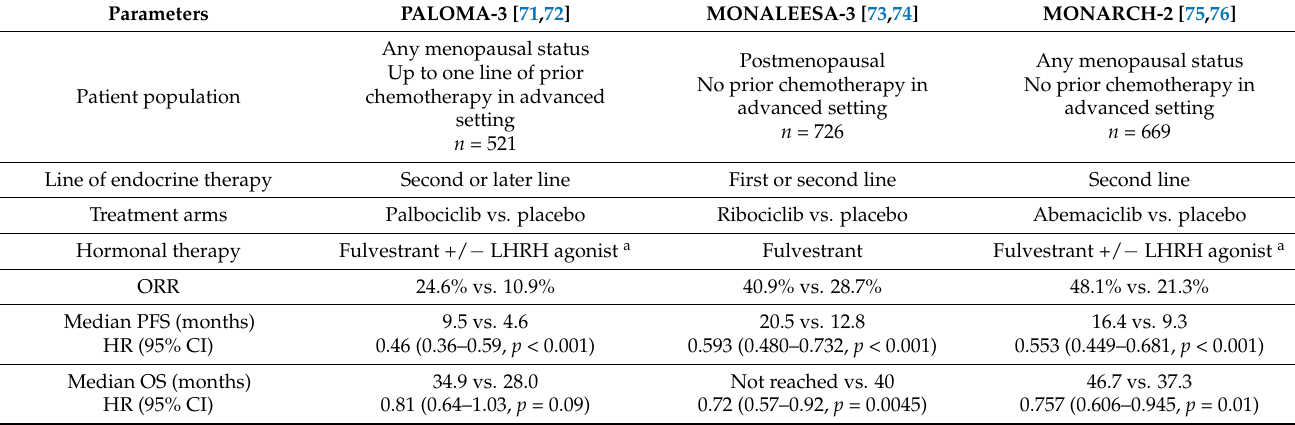
Table 4. Clinical data of CDK 4/6 inhibitors with fulvestrant in women with HR+ advanced breast cancer who progressed on adjuvant or 1st line endocrine